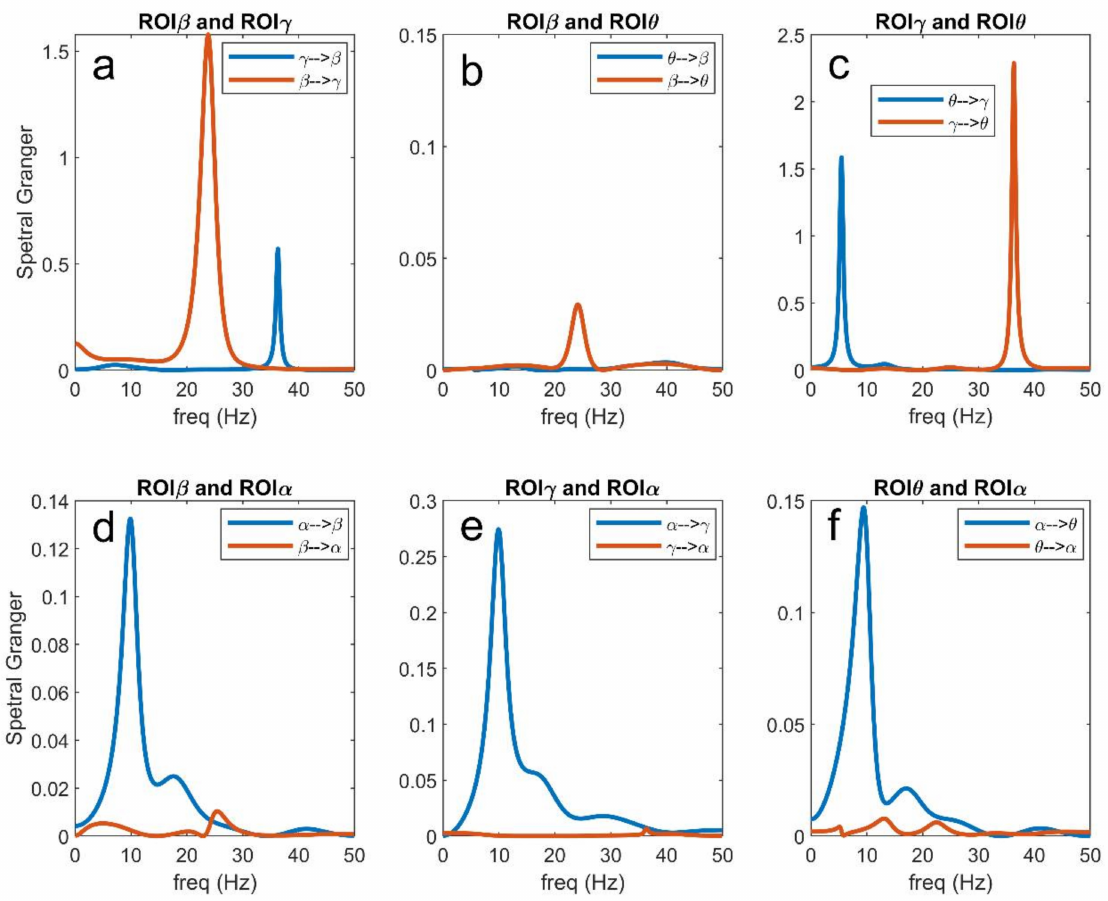
Figure 11. Values of connectivity among the ROIs estimated with the spectral Granger causality with reference to the network in Figure 2A and plotted as a function of frequency (note the use of different y -axes to emphasize the different cases). The estimator reproduced the network connectivity quite well: the exchange of rhythms between ROI β and ROI γ ( a ) and between ROI γ and ROI θ ( c ) is evident; the coupling between ROI θ and ROI β is negligible ( b ); and the α rhythm is clearly transmitted from ROI α to the other regions ( d – f